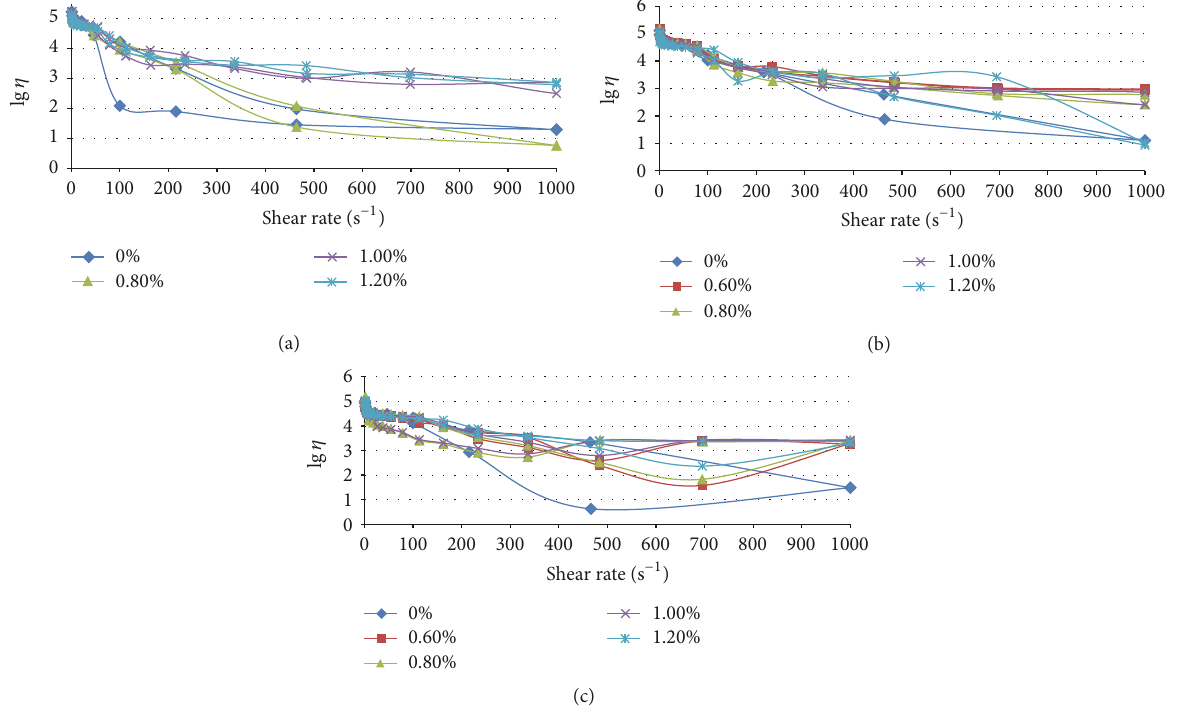
Figure 9: Curves of thixotropy of samples at temperatures, ∘ b : (a) 80; (b) 85; (c) 90. Table 10: Results of laboratory tests of oxidized bitumen